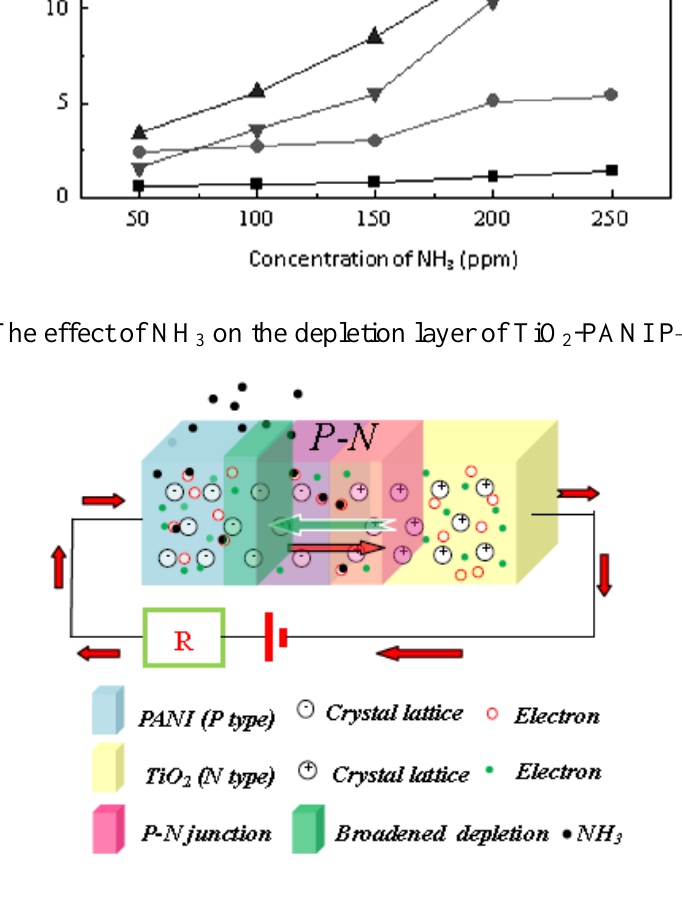
Figure 7. Sensitivity of (a) PANI/PA6; (b) TiO (c) TiO -PANI/PA6 sputtered for 60 min and (d) TiO 2 ammonia vapor of different concentrations.